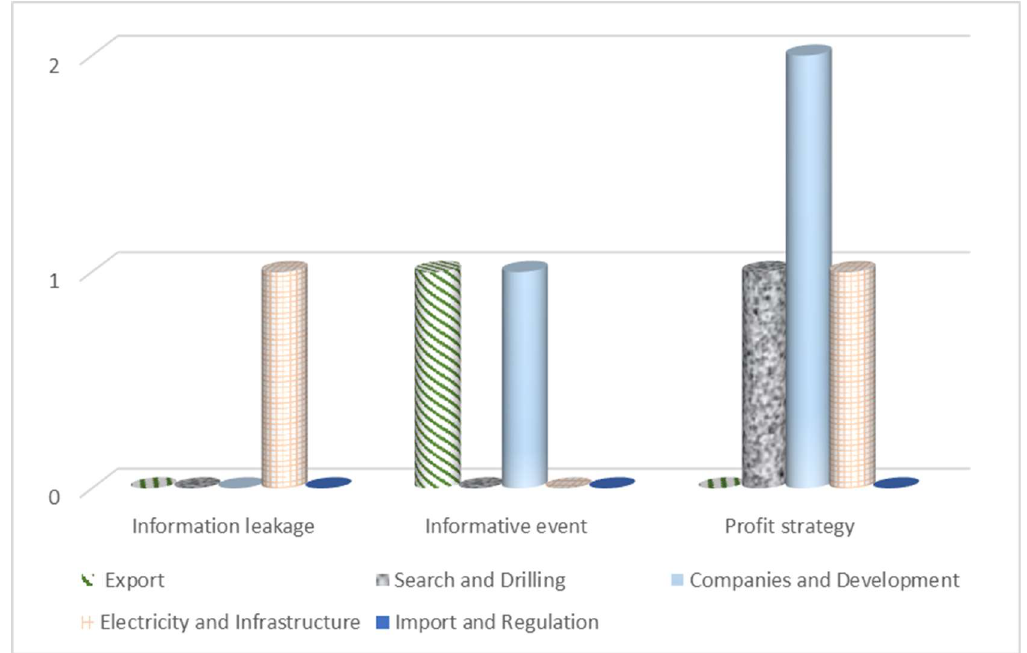
Figure 5. Summary of results according to five groups of announcements.